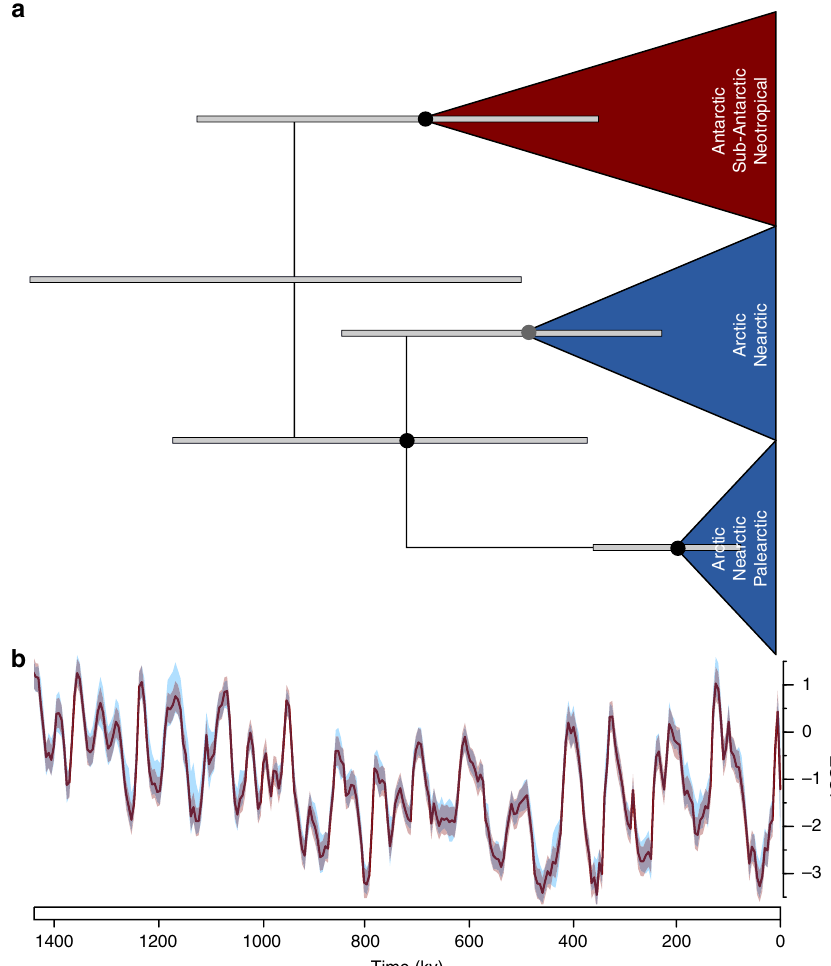
Fig. 4 Phylogeography of a P. borealis species. a Molecular time-calibrated phylogeny of P. borealis species JRI15_10_06, the most common and widely distributed species in this study, based on a 3-gene alignment (28S, cox1 , rbcL ), showing three major metapopulations. The grey bars represent the 95% HPD (highest probability density) age-intervals. Colored circles represent BEAST posterior probabilities: black > 95, and grey > 90. A more detailed phylogeny is given in Supplementary Fig. 13c. b Global delta sea surface temperatures ( Δ SST) over the last 1.4 Ma, based on ref. 40 . The dark red line indicates the Δ SST, and the transparent bands show the 95% con fi dence interval based on variability (red) and jackknife